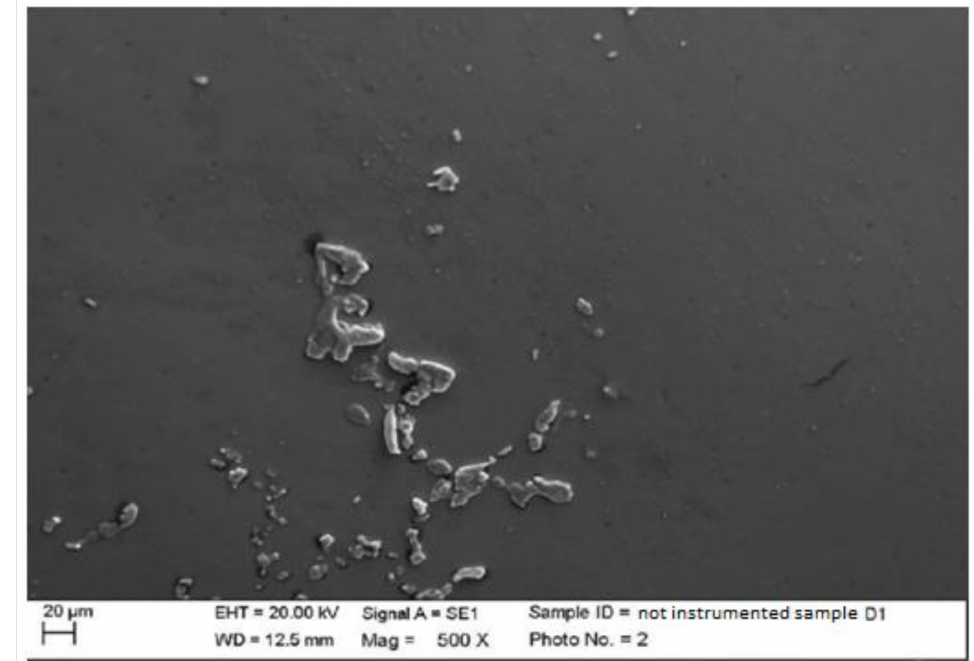
Figure 3. Non-instrumented disilicate sample D1 (500 × ).